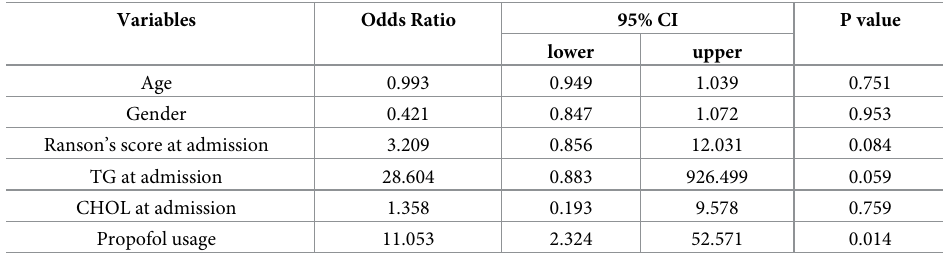
Table 6. Logistic regression analysis of risk factors for developing TG elevation in N-TG patient group.